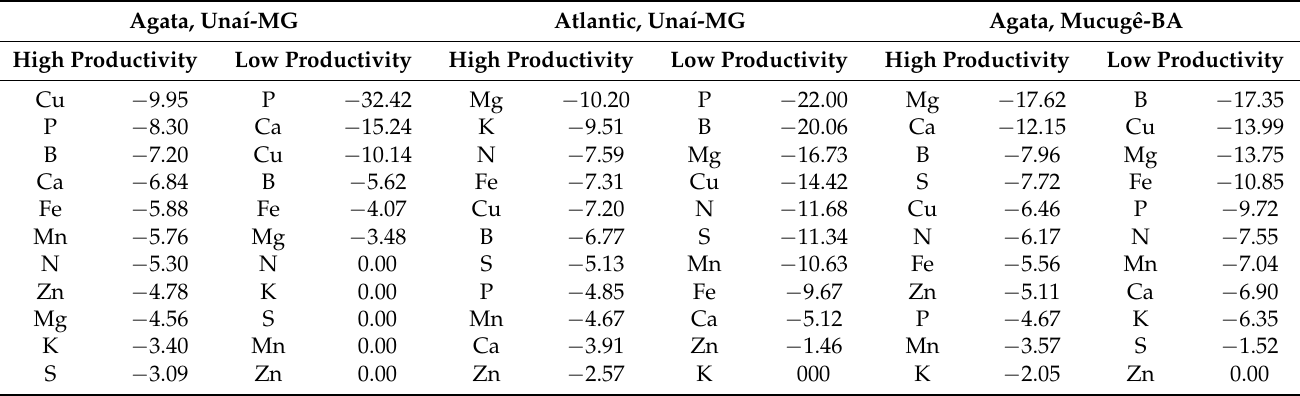
Table 5. Nutrient deficiency index for macronutrients and micronutrients in high and low productivity areas for cultivars Agata, Una í -MG; Atlantic, Una í -MG; and Agata, Mucug ê -BA. Agata, Una í -MG Atlantic, Una í -MG Agata, Mucug ê -BA High Productivity Low Productivity High Productivity Low Productivity High Productivity Low Productivity